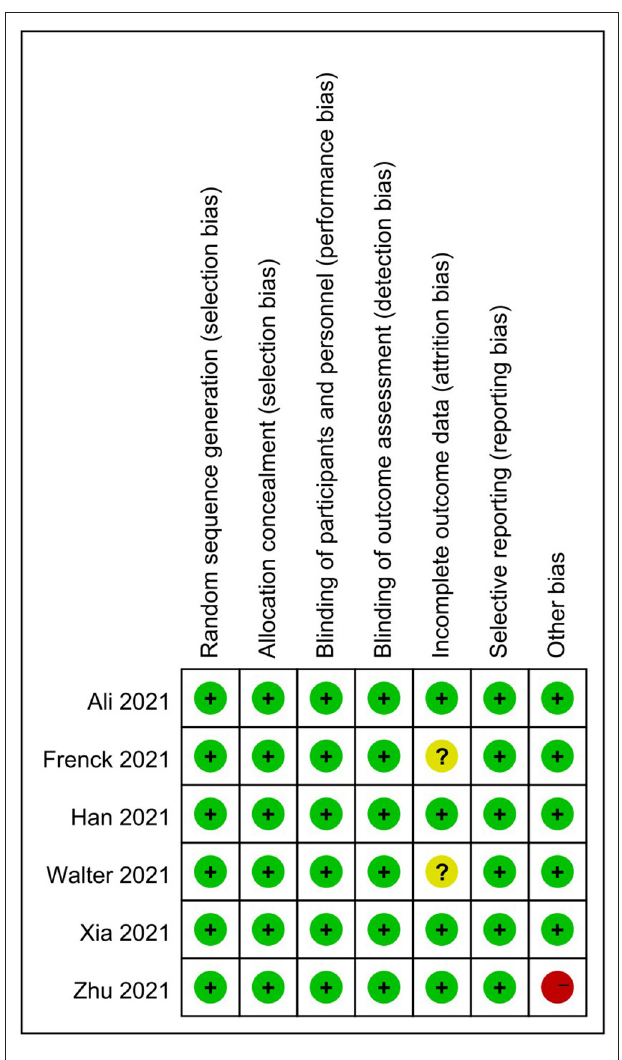
FIGURE 3 | Risk of bias summary for included